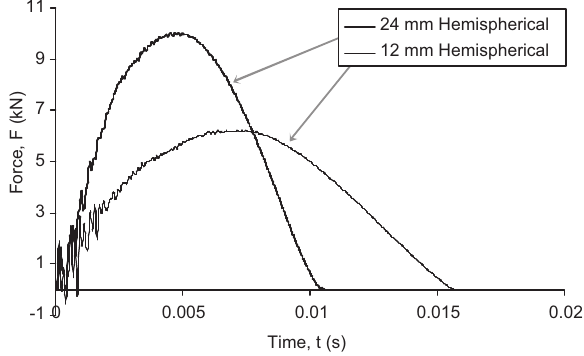
Figure 3 Force - time histories from the tests realized by hemispher- ical